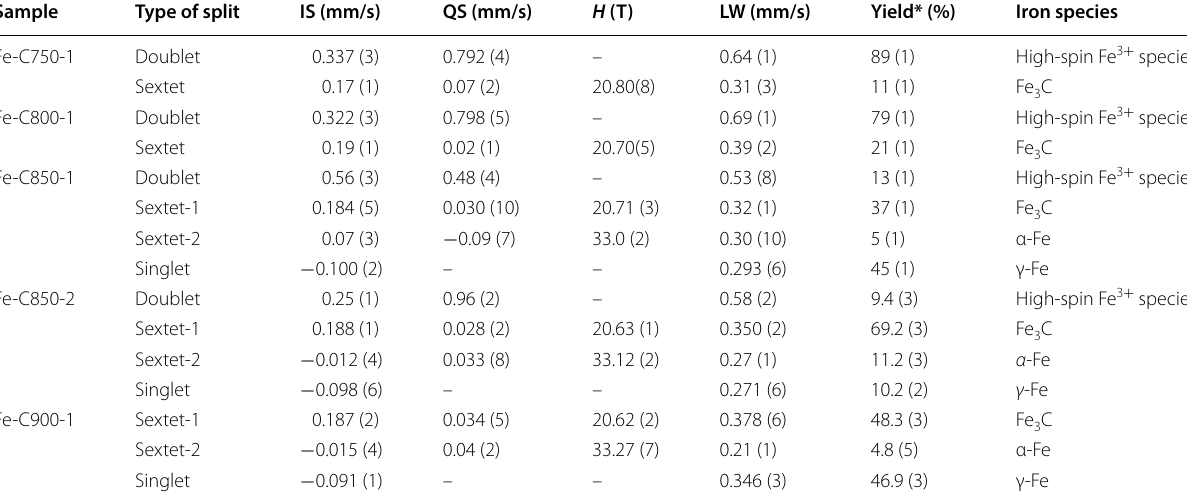
IS, isomer shift; QS, quadrupole splitting; H , internal magnetic field; T, tesla; LW, linewidth * Yields of iron species were calculated from their Mössbauer absorption areas